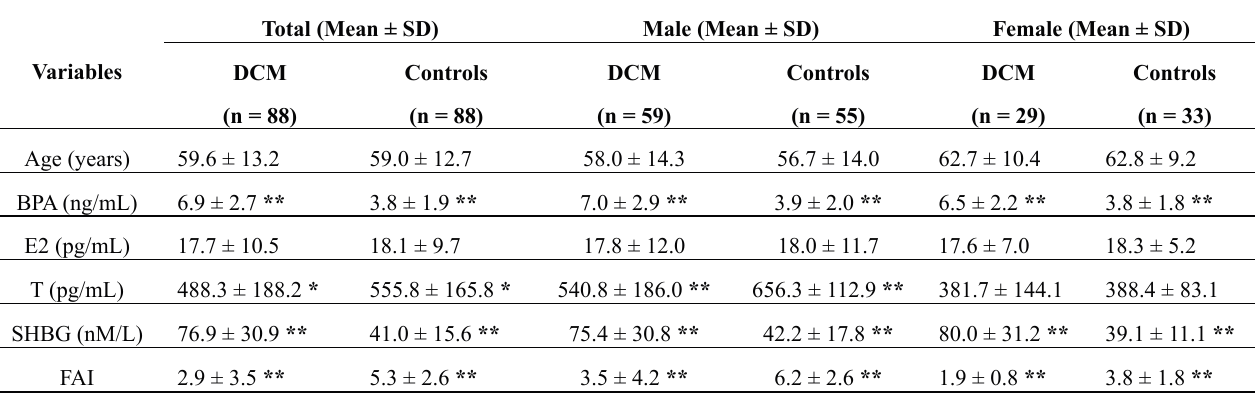
Table 2. Results in the total group, as well as in male and female